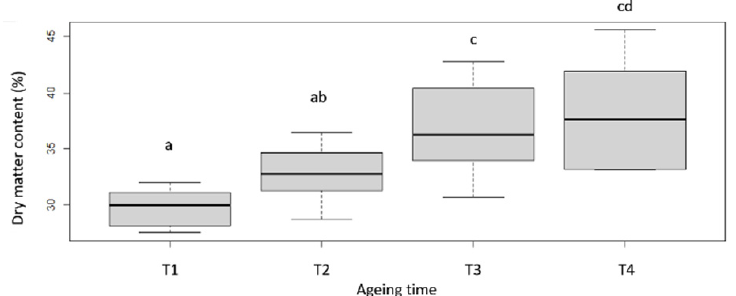
Figure 1. DM evolution with ageing time. T1, T2, T3 and T4 correspond with the different ageing length (respectively 7, 16, 35 and 60 days). Box-plot explanation: the central value represents the median; the edges of the rectangle are the quartiles and the extremities are calculated using 1.5 times the interquartile range. a, b, c, d: significant differences ( p <